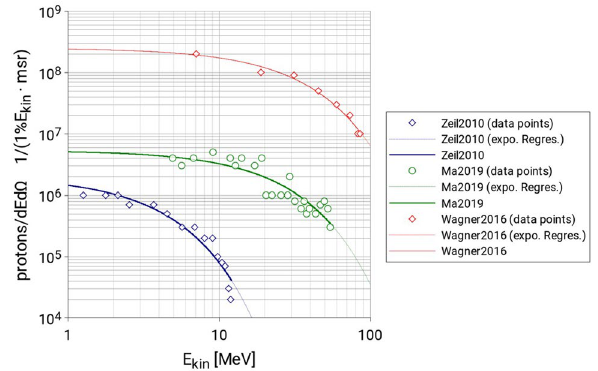
Figure 3. Primary proton spectrum data as reported by Schreiber in 22 with exponential regression applied (dashed lines). Proton spectra found applying the exponential regression to the proton spectrum data (solid